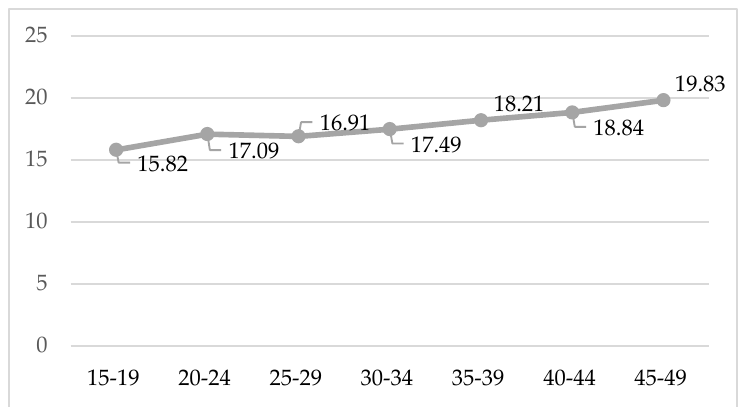
Figure 1. Age at the first sexual relationship according to age group.